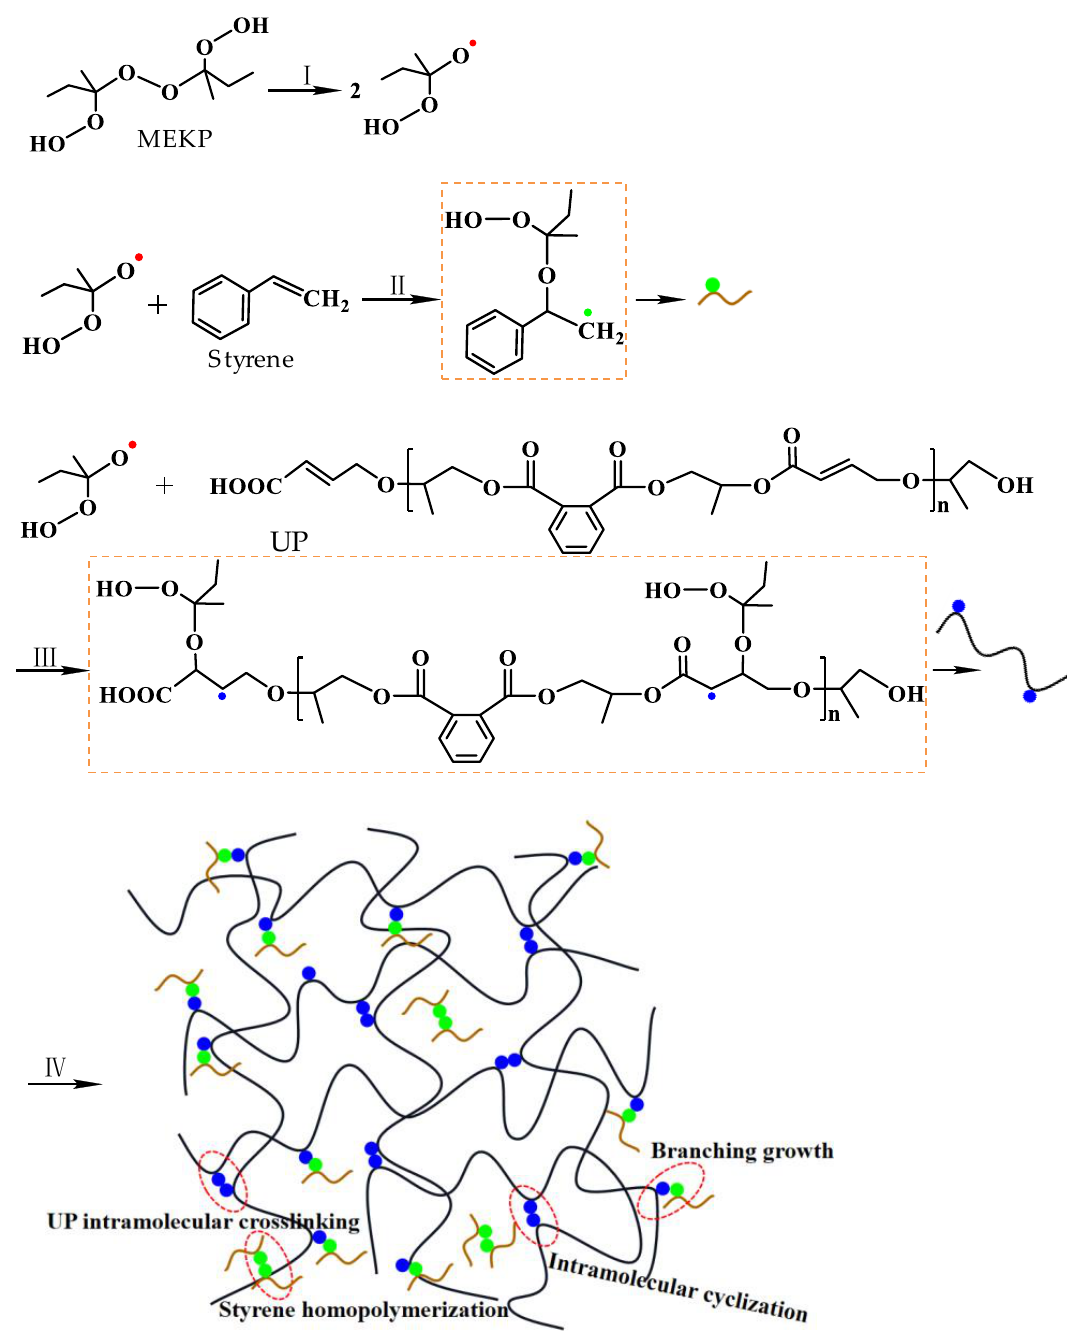
Figure 2. Schematic diagram of UPR curing.